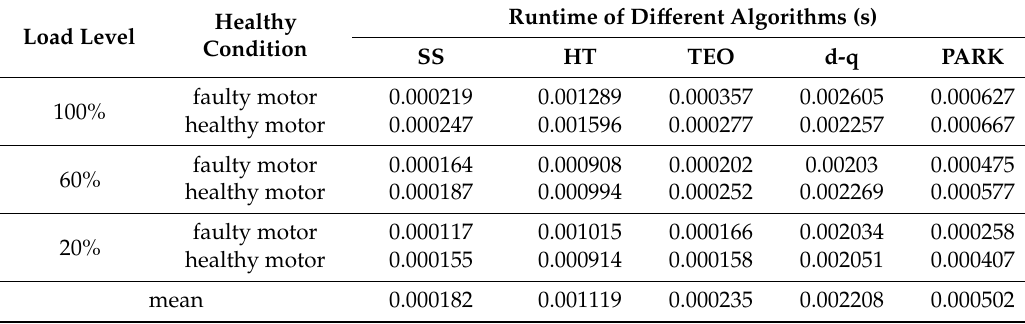
Table 3. The runtime of di ff erent